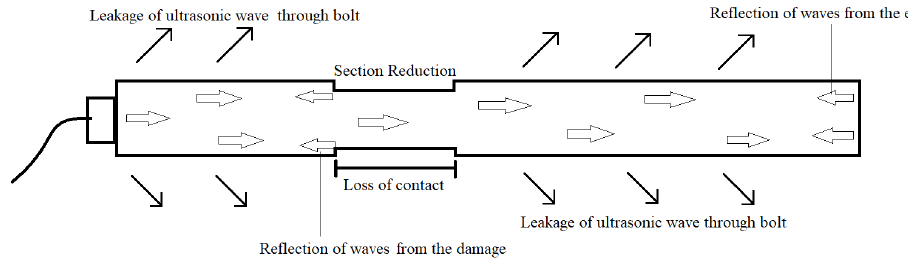
Figure 4. Transmission, reflection, and leakage of the ultrasonic wave pulse through a bolt.